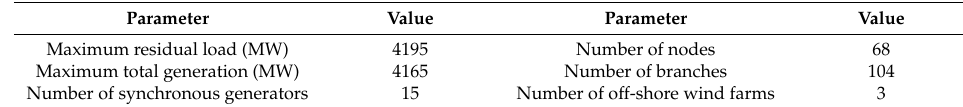
Table A2. Transmission grid overview data.